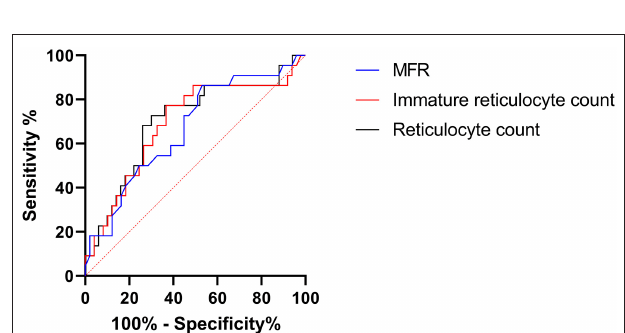
FIGURE 2 | Roc curve of vaso-occlusive crisis prediction by reticulocyte parameters. MFR, medium fluorescent reticulocytes. Immature reticulocyte count: absolute value of immature